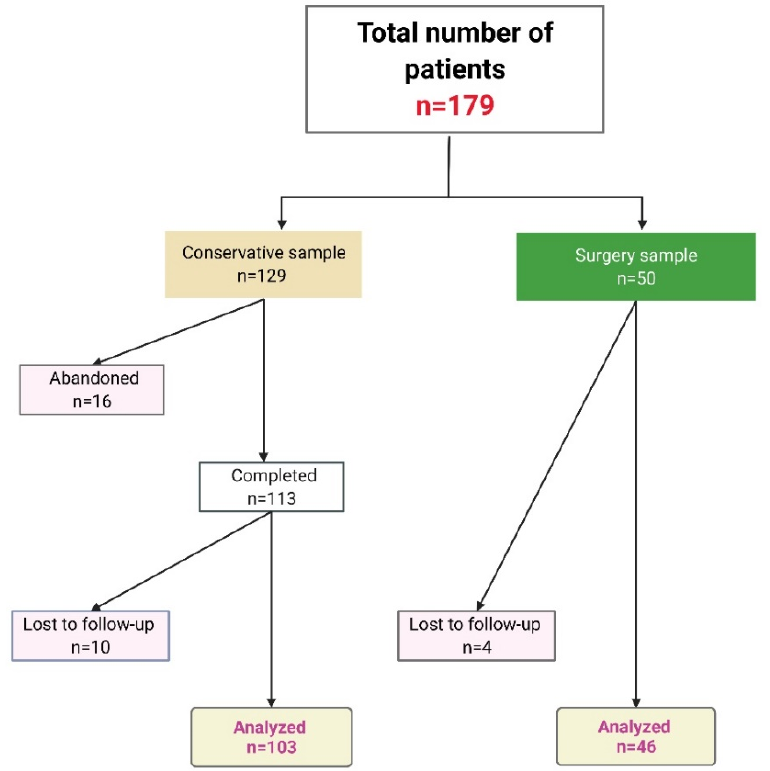
Figure 2. Subjects’ disposition in conservative and surgical subgroups. Table 1. Demographic, clinical, and histopathological